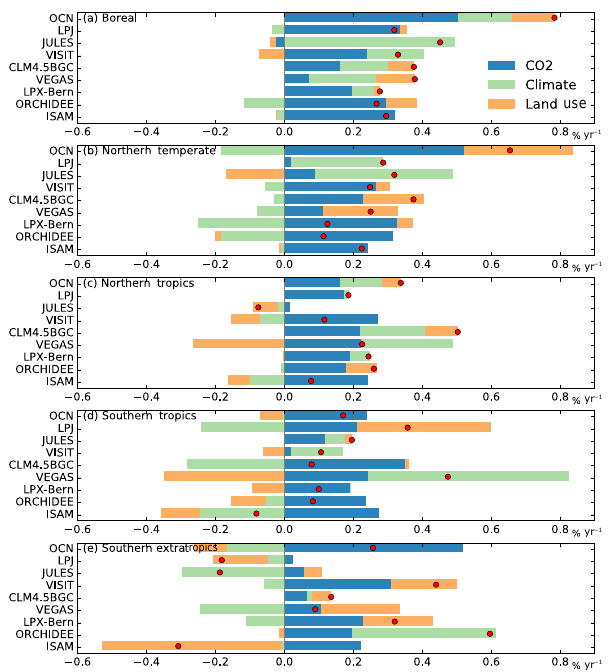
Figure 6. Attribution of the seasonal amplitude trend of regional (boreal (50–90 ◦ N), northern temperate (23.5–50 ◦ N), northern tropics (0–23.5 ◦ N), southern tropics (0–23.5 ◦ S) and southern ex- tratropics (23.5–90 ◦ S)) net land carbon flux for the period 1961– 2012 to three key factors CO 2 , climate and land use/cover. The red dots represent models’ global amplitude increase of F TA from the S3 experiment. The increasing seasonal amplitude of F TA is decom- posed into the influence of time-varying atmospheric CO 2 (blue), climate (light green) and land use/cover change (gold).